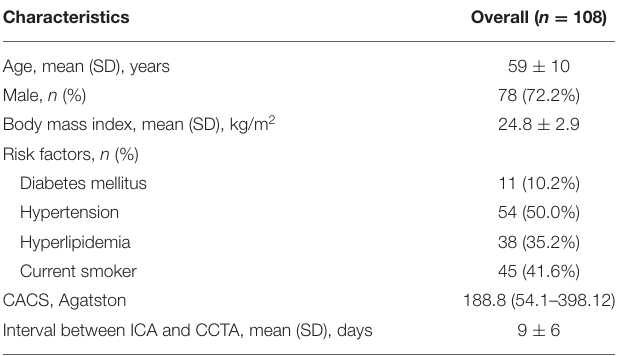
TABLE 1 | Patients